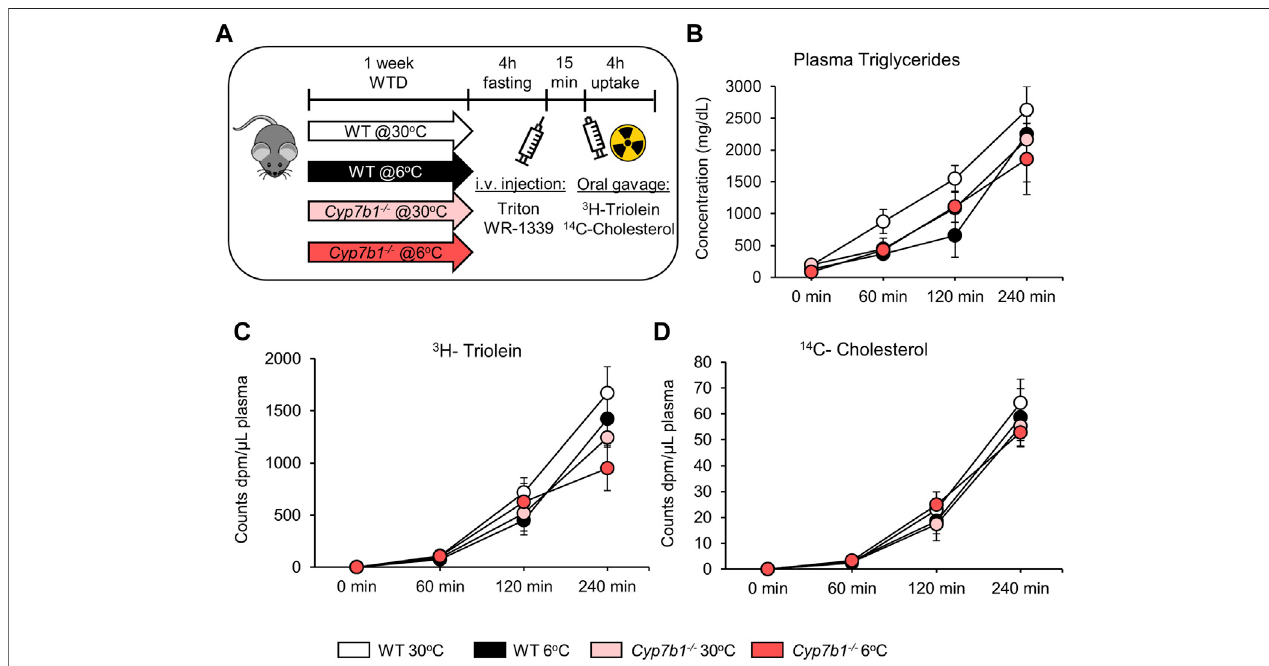
FIGURE 4 | Cyp7b1 deletion does not affect intestinal chylomicron production in response to cold exposure. WT and Cyp7b1 − / − littermates were fed a WTD and housed for 1 week either at a thermoneutral (30 ° C) or cold (6 ° C) environment. Then 15 min before the 3 H-triolein/ 14 C-cholesterol-traced lipid gavage, mice were intravenously injected with Triton WR-1339 to inhibit intravascular lipoprotein hydrolysis and follow the accumulation of intestinal secreted chylomicrons. Experimental setup (A) , triglyceride (B) , 3 H-triolein (C) ,and 14 C-cholesterol (D) levelsintheplasmabetween 0and 240 min post-gavage(n=5/group).Dataare shown asmean values ±SEM. Different letters indicate signi fi cant differences between groups ( p < 0.05) determined by two-way